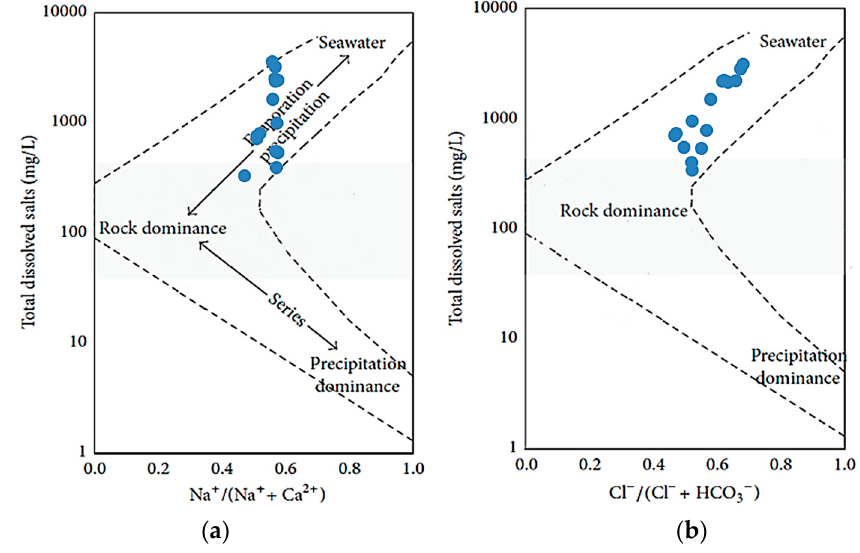
Figure 4. Gibbs diagram depicting dominant hydrogeochemical processes: ( a ) TDS vs Na + /(Na + +Ca 2+ ); ( b ) TDS vs Cl − /(Cl − + HCO 3 − ).